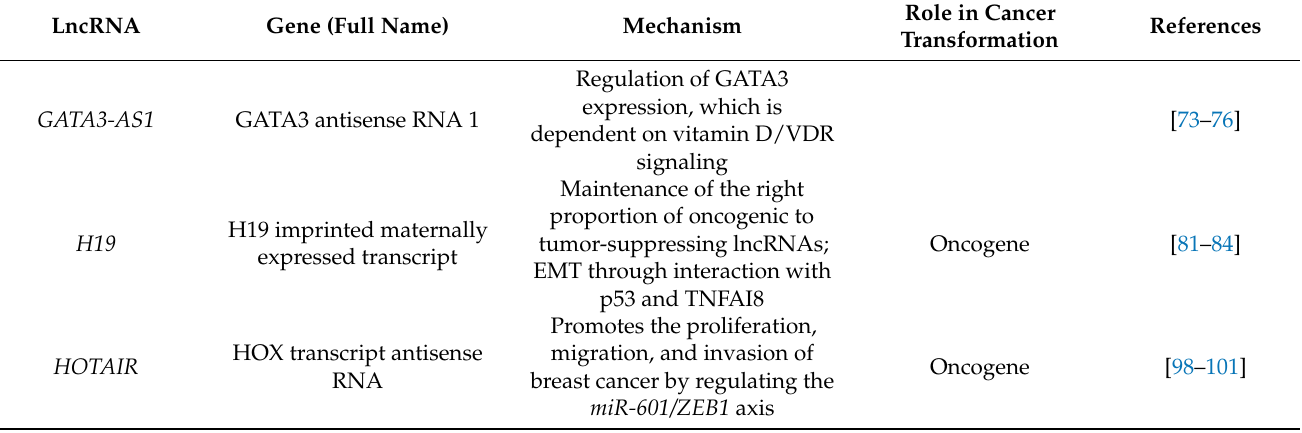
Table 2. Long noncoding RNAs that are putative candidates to mediate the effect of vitamin D3 in breast cancer. Some mechanisms underlying such possible effects are also presented. Abbreviations are defined in the main